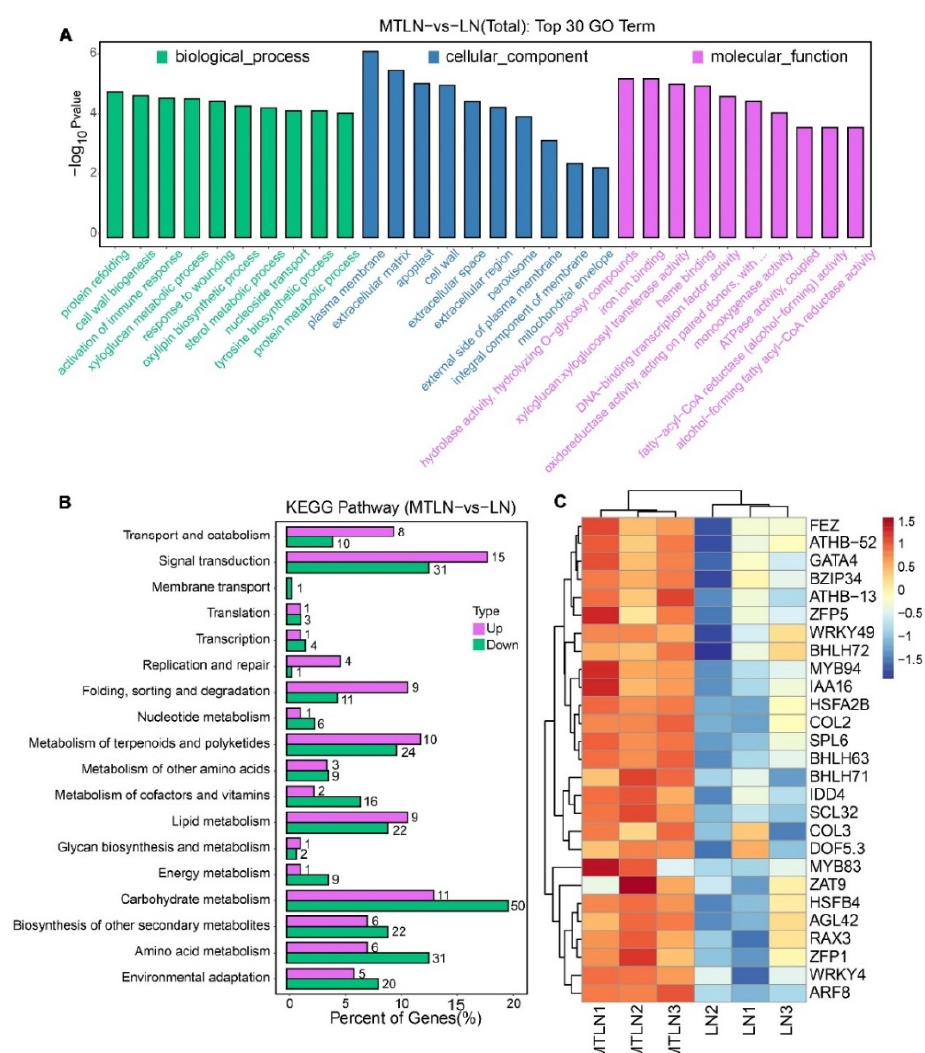
Figure 6. Go and KEGG enrichment analyses of melatonin in the regulation of DEGs in tomato leaves at low night temperatures. Analysis of enriched GO terms ( A ), KEGG metabolic pathways ( B ), and selected transcription factors upregulated by melatonin at low night temperature ( C ).